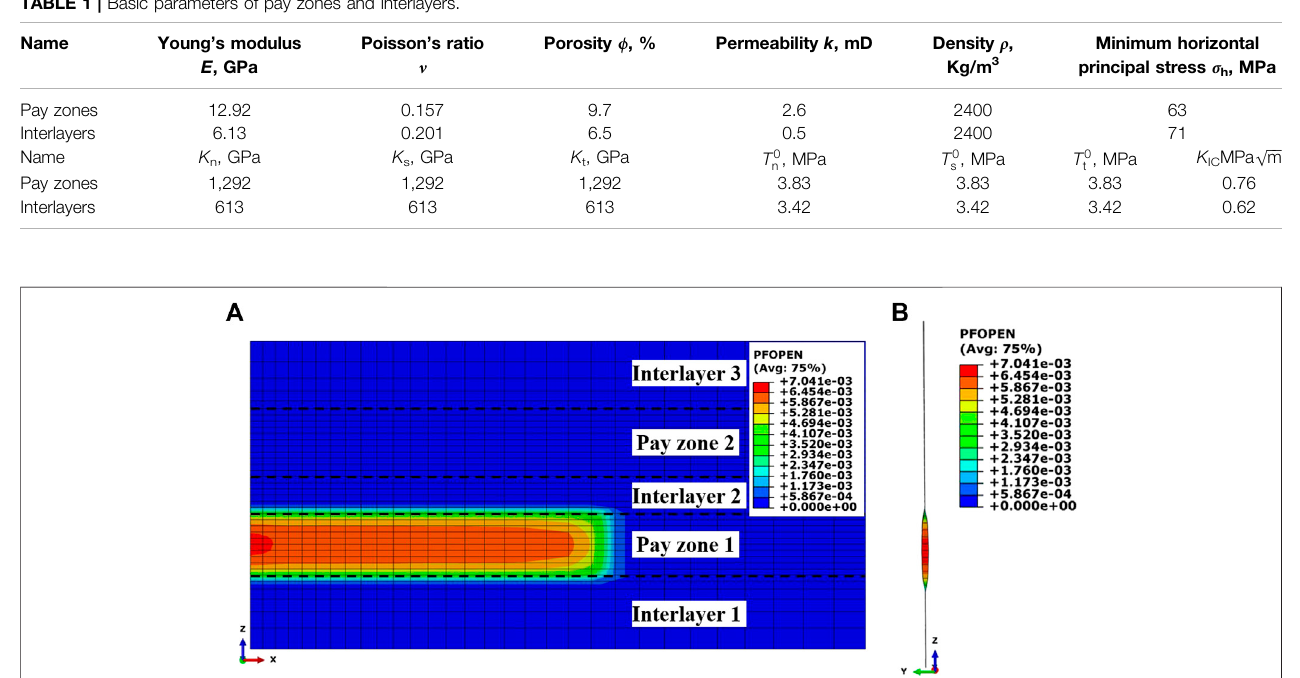
FIGURE 3 | Hydraulic fracture geometry when pay zone 1 is treated. (A) X – Z view; (B) Y – Z view.